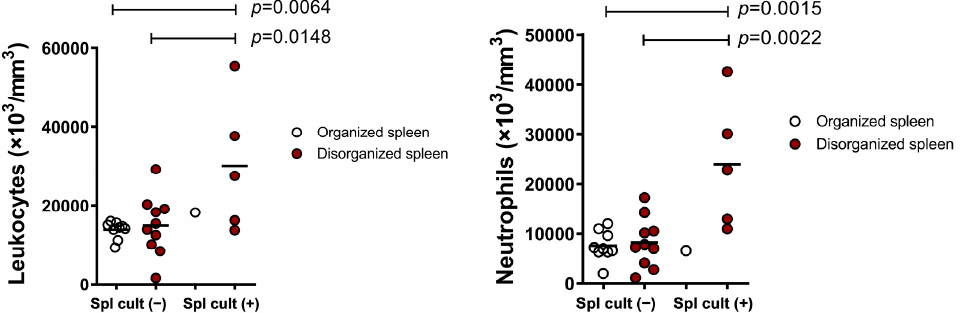
Figure 3. Hematological alterations presented by dogs with active infection of L. infantum associated with splenic disorganization. Spl cult ( − ) = negative splenic culture; Spl cult (+) = positive splenic culture. (Mann–Whitney and Student’s t -test.)